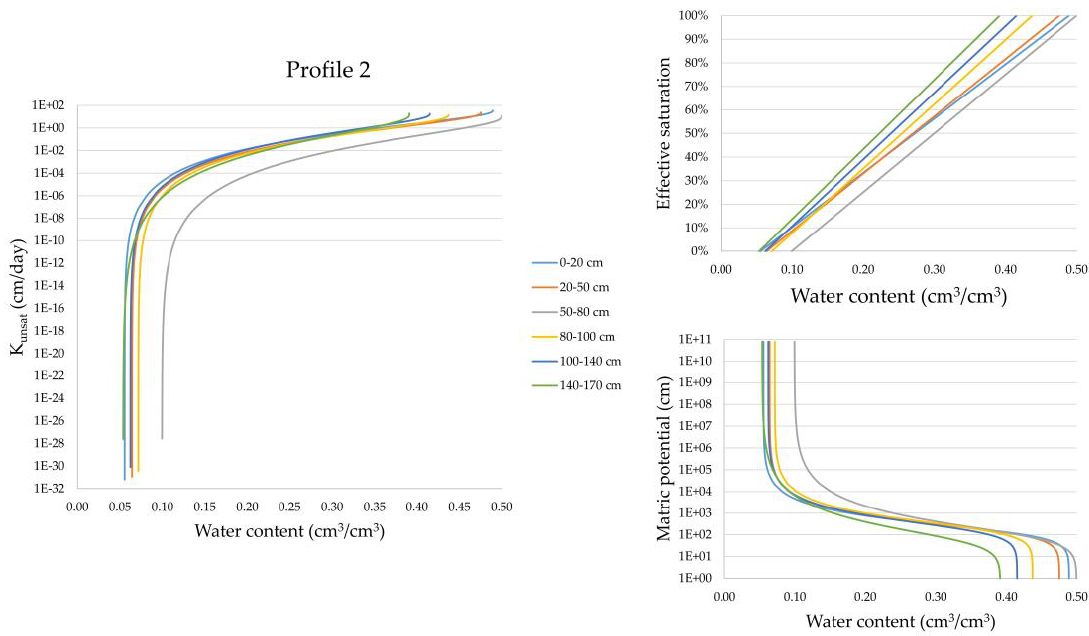
Figure 4. SWRCs, e ff ective saturations, and unsaturated hydraulic conductivities in soil profile Figure 4. SWRCs, effective saturations, and unsaturated hydraulic conductivities in soil profile 2.